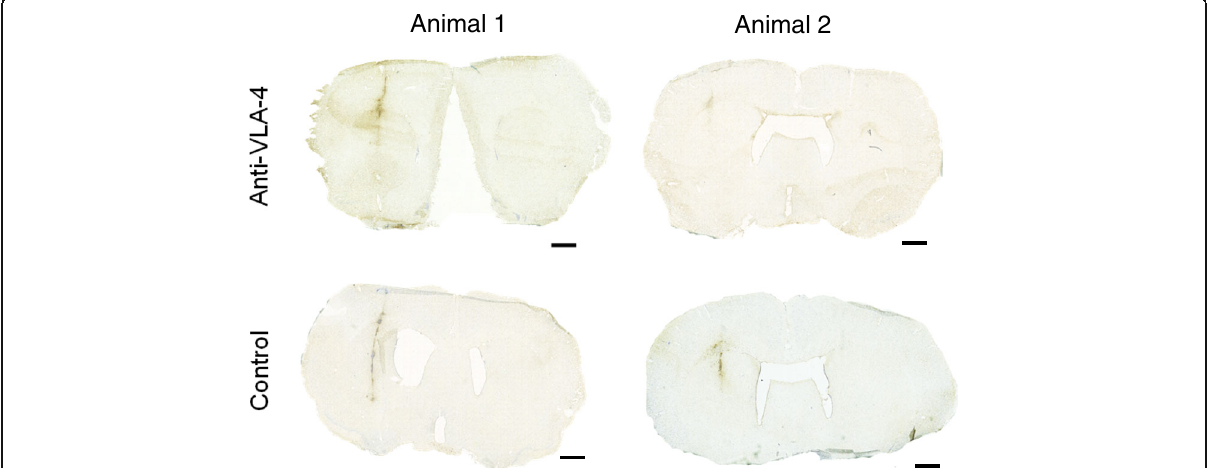
Fig. 4 IHC staining with anti-Iba-1 of anti-VLA-4 mAb-treated and control animals after treatment over 14 days. Stereotaxic injection of BCG was performed on day − 28 ( n = 4), and activation of the lesion was performed on day 0. Anti-VLA-4-treated animals were treated every third day on days 30 – 44 with anti-VLA-4 mAb ( n = 2), and the control animals were treated with an isotype-matched control mAb ( n = 2). The scale bar in each figure is 1500 μ m. BCG Bacille Calmette-Guérin, Iba - 1 ionised calcium-binding adapter molecule 1, IHC immunohistochemical, mAb monoclonal antibody, VLA - 4 very late